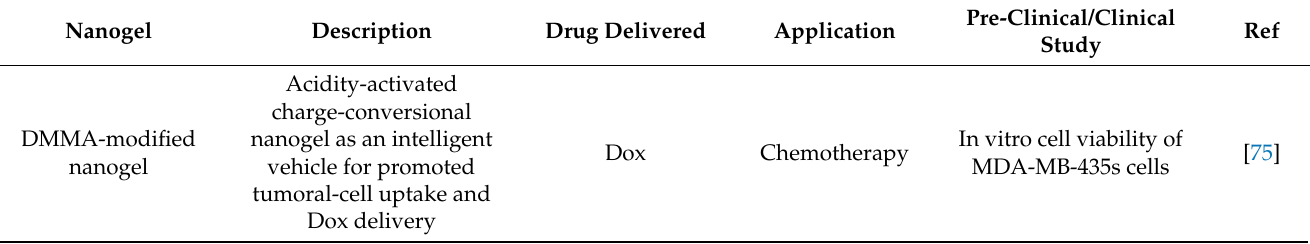
Table 2. Characteristics and general biomedical applications of different types of nanogels in